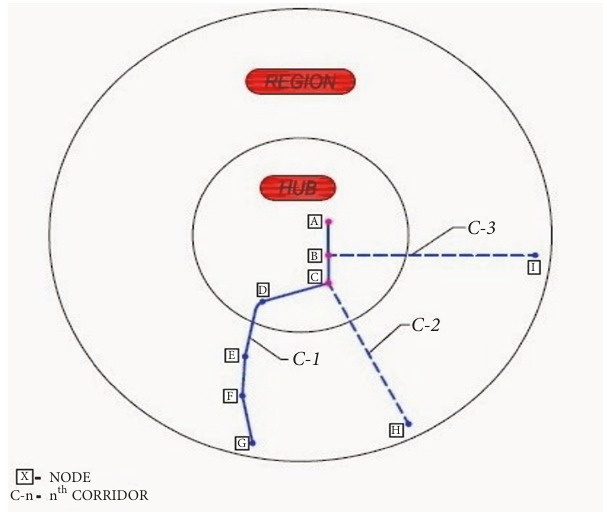
Figure 5: Distributed terminal network